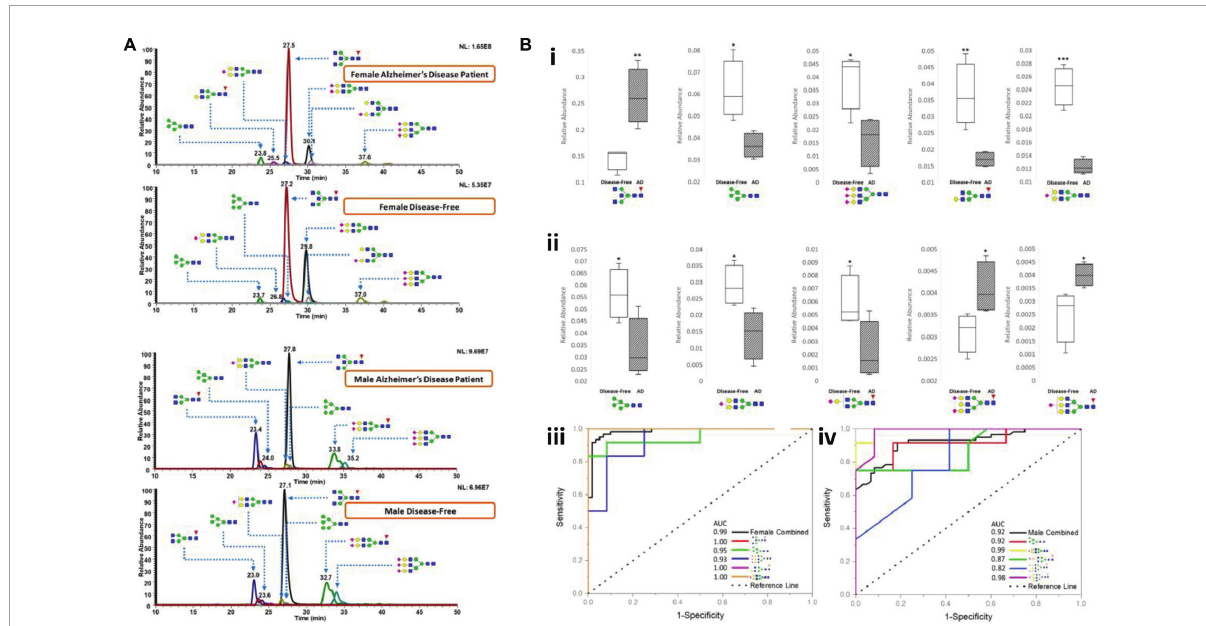
FIGURE4 (A) Representative chromatograms of various N-glycans, comparing N-glycan expression in CSF between female AD patients and female disease-free, and between male AD patients and male disease-free. (B) Box and ROC plots depict the comparison between relative abundances of N-glycan structures in female CSF (i) and in male CSF (ii) that are statistically significant among the abundant structures. Solids, disease-free; stripes, Alzheimer’s disease. ROC curves for female (iii) and male (iv) . Some of the plots are hidden due to overlapping. Blue square, N-acetylglucosamine (GluNAc); yellow square, N-acetylgalactosamine (GalNAc); green circle, mannose; yellow circle, galactose; red triangle, fucose; purple diamond, sialic acid. Reproduced with the modification and permissions from Cho et al. (2019). * p < 0.05; ** p < 0.01; and *** p <